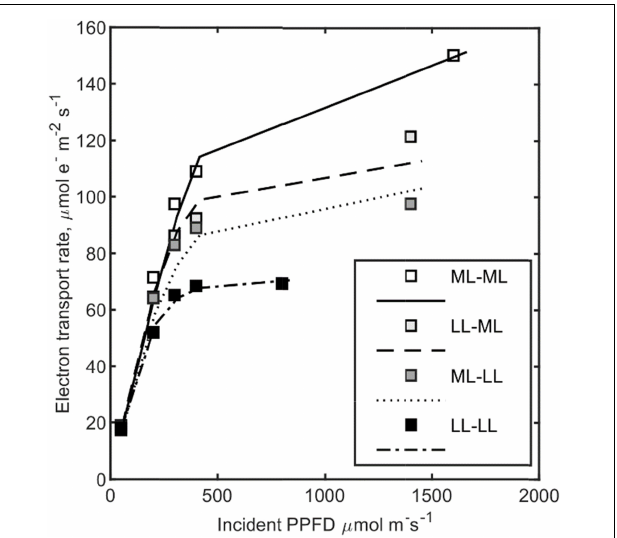
FIGURE 5 | Measured electron transport rates (symbols) and predictions by Equation 6 (lines) vs. incident photosynthetic photon flux density (PPFD) at 7 days after a step change in light intensity for cucumber leaves (Trouwborst et al., 2011b), ML-ML (I 1 :200 → I 2 :200 µ mol m 2 s − 1 ), LL-ML (I 1 :50 → I 2 :200 µ mol m 2 s − 1 ), LL-ML (I 1 :200 → I 2 :50 µ mol m − 2 s − 1 ), and LL-LL (I 1 :50 → I 2 :50 µ mol m − 2 s − 1 ). Plants were measured after 7 days growing at intensity I 2 . Lines connect computations at assessed PPFD (i.e., symbols). n = 20, root mean squared error = 4.22 µ mol e − m − 2 s − 1